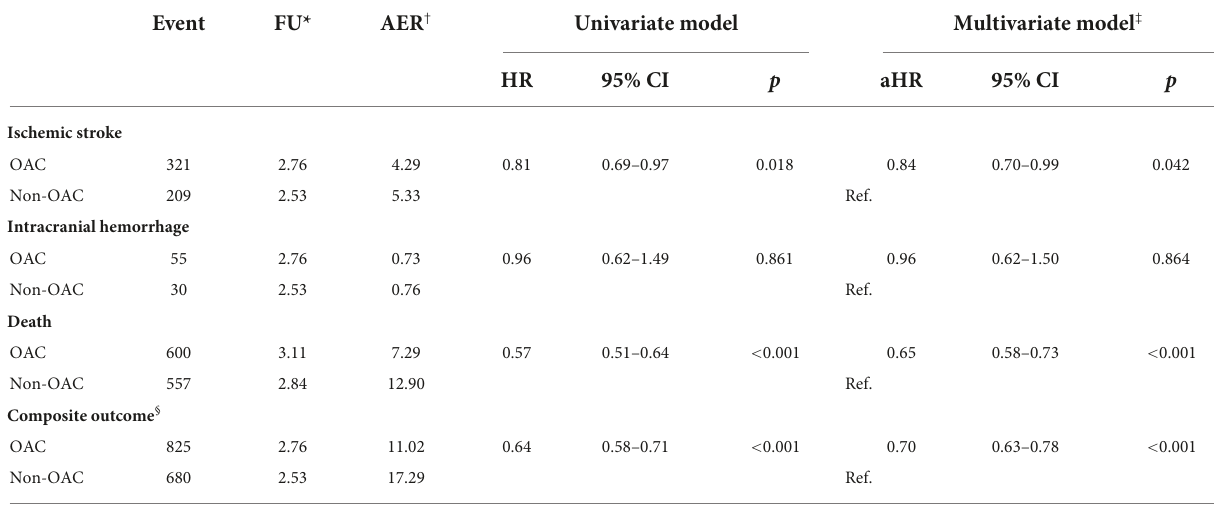
TABLE 2 Risk of ischemic stroke and secondary outcomes in IPTW